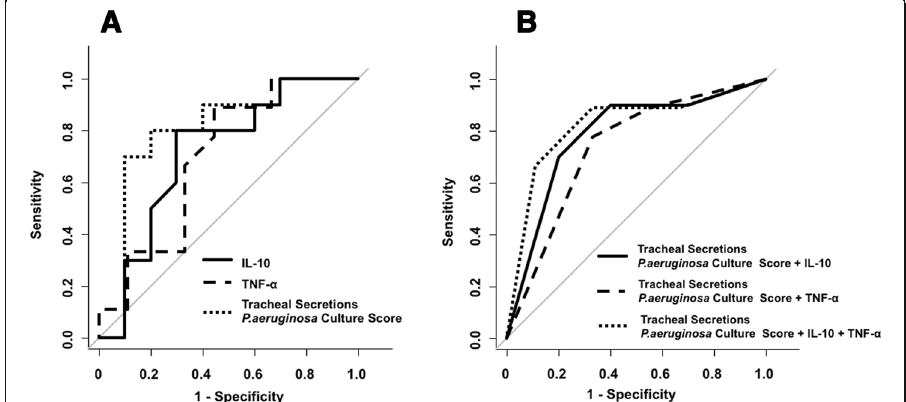
Fig. 3 Analysis of the receiver operating characteristics curves. a Analysis of the receiver